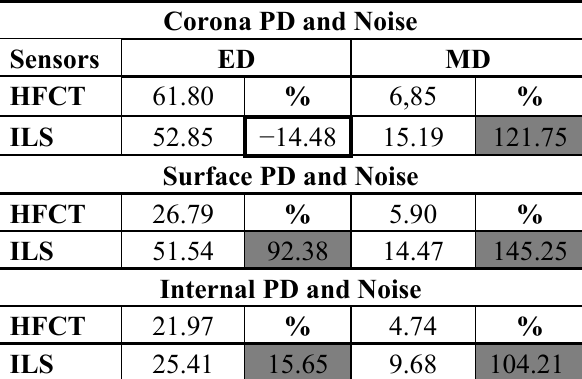
Table 4. MD and ED between clusters obtained with the two sensors for the intervals. PRL [0, 20] MHz and PRH [20, 40] MHz.